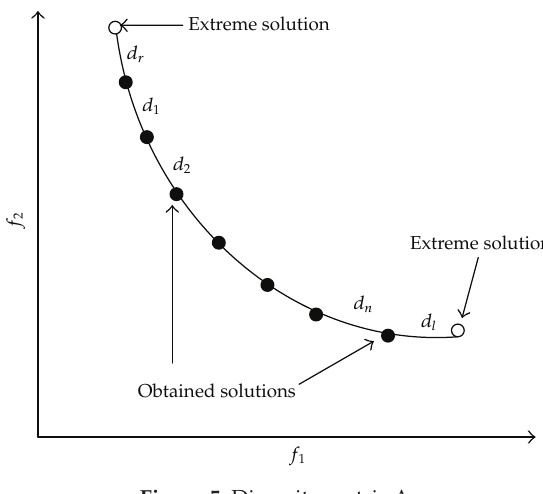
Figure 5: Diversity metric Δ